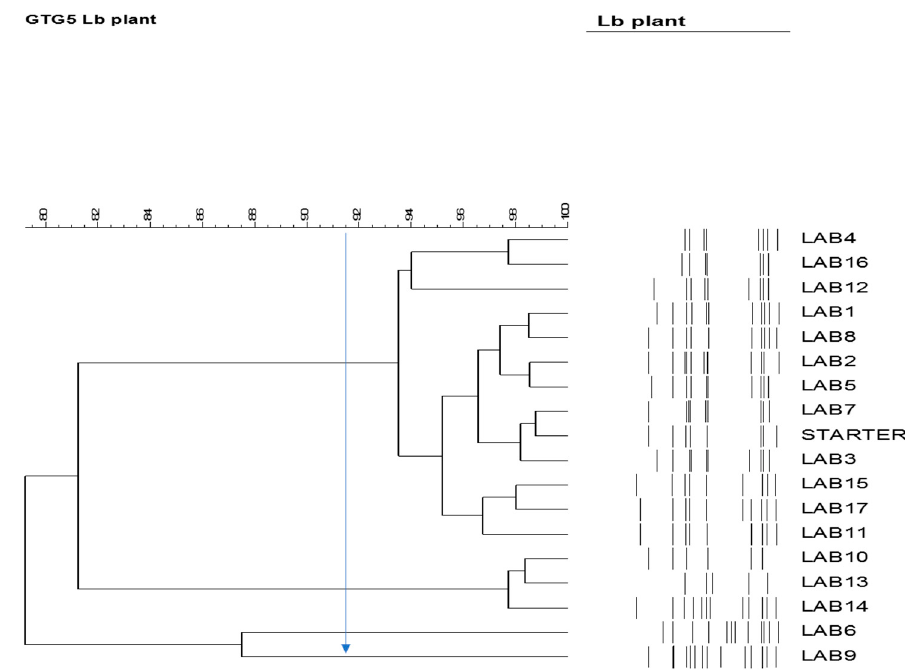
Figure 10. Dendrogram generated after cluster analysis of the digitized GTG5-PCR fingerprints of LAB (lactic acid bacteria) strains isolated from AL7 (LAB 6,9), AL8 (LAB 1,2,3,4,5,7,8), and AL9 (LAB 10,11,12,13,14,15,16,17) brine samples at 120 days of fermentation.